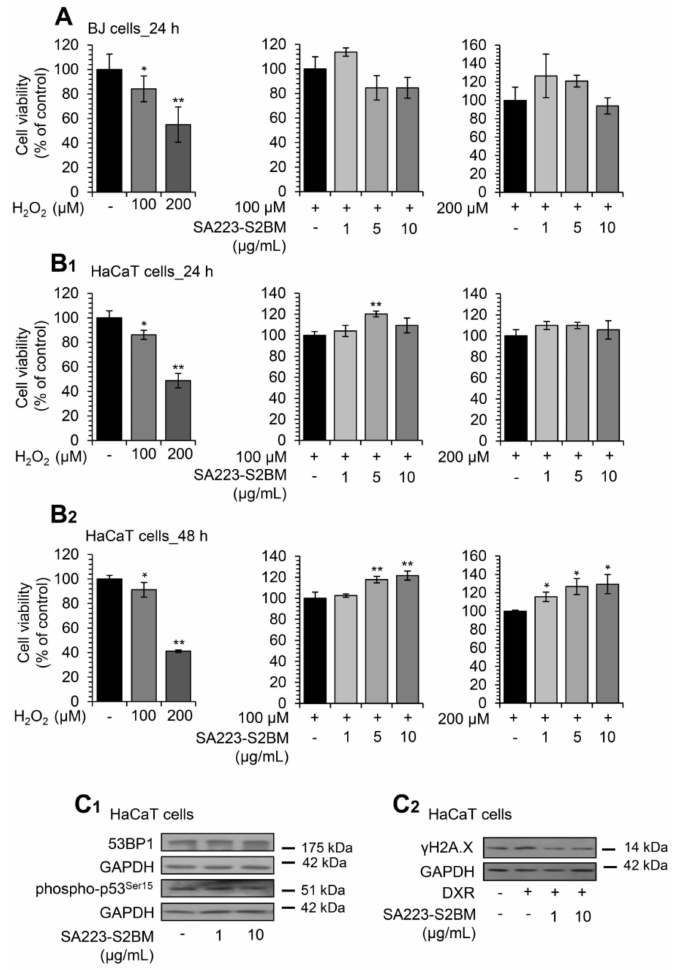
Figure 7. The extract SA223-S2BM confers protection to cells against oxidative and genotoxic stress. ( A ) Relative (%) survival levels (MTT assay) of BJ fibroblasts co-incubated with the oxidative agent H 2 O 2 (at concentrations of 100 and 200 µ M) and the indicated concentrations of the SA223-S2BM extract for 24 h. ( B 1 , B 2 ) Relative (%) survival levels (MTT assay) of HaCaT keratinocytes co-incubated with H 2 O 2 at the concentrations of 100 and 200 µ M and the indicated concentrations of the extract for 24 ( B 1 ) and 48 ( B 2 ) h. ( C 1 ) Representative immunoblotting analyses of the expression levels of 53BP1 and the Ser15 phosphorylated form of p53 after exposure of HaCaT cells to the shown concentrations of the extract for 24 h. ( C 2 ) Representative immunoblotting analyses of the Ser139 phosphorylated form of histone H2A.X ( γ H2A.X) in HaCaT cells treated for 24 h with 2 µ M DXR in the presence or not of the shown concentrations of the extract. In ( A , B 1 , B 2 ), control samples values were set to 100%. In ( C 1 , C 2 ), GAPDH probing was used as reference for protein input. Quantitation of shown blots is presented in Figure S6. Bars, ± SD ( n ≥ 2); * p < 0.05; ** p <